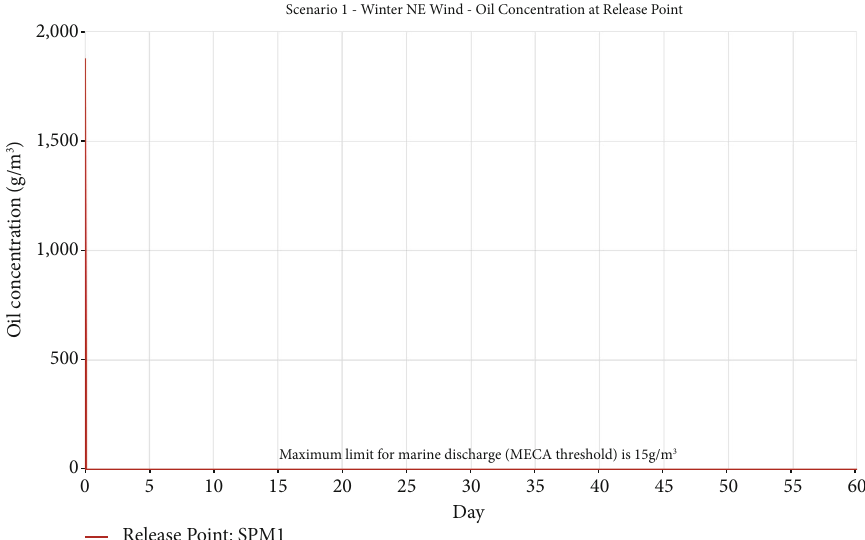
Figure 15: Changes in oil concentration over time at SPM1 spill location for scenario 1 (subsurface blowout: 16,000 m 3 spill at SPM1) (under typical winter wind